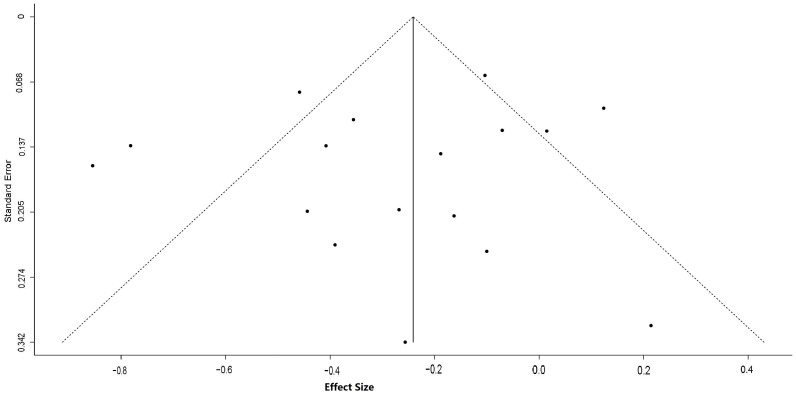
Funnel plot of 15 studies (17 interventions) for assessing publication bias. X-axis (horizontal) for the effect size or standard difference in means; y-axis (vertical) for the standard error of effect size.